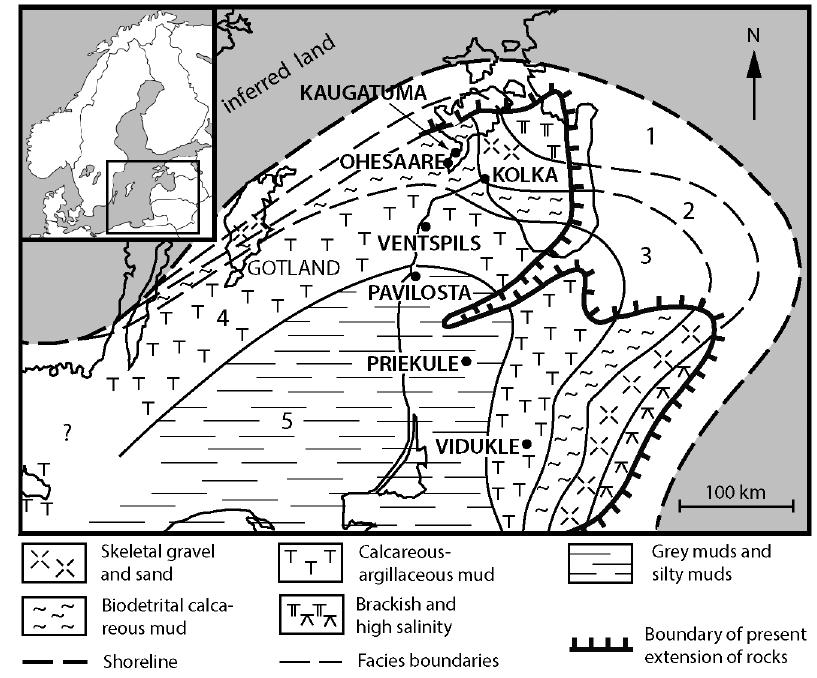
Fig. 1. Location of the discussed core sections on the background of the general facies zonation of the Baltic Gulf in early Ludlow time. Modified from Bassett et al. (1989) and Kaljo & Martma (2006). Facies belts (signature shows the presence of sediments, white area – postsedimentary erosion or no data): 1, tidal-flat–lagoonal; 2, high-energy shoal-bar; 3, open shelf, mid-ramp (facies 1–3 form shallow carbonate shelf in Fig. 2); 4, offshore shelf, outer ramp; 5, ramp/shelf